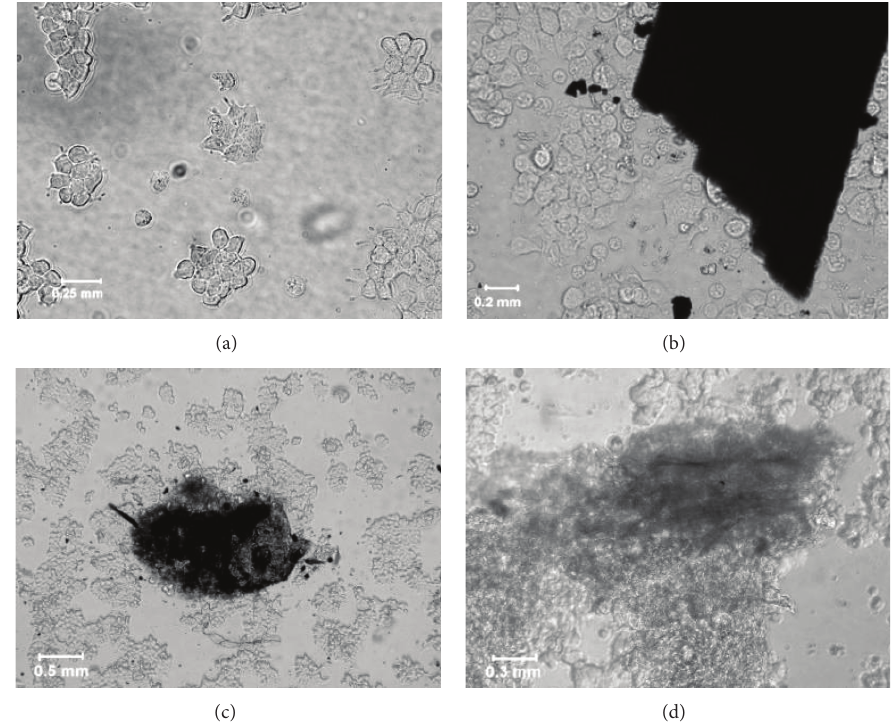
Figure 2: The rin-mf5 cell proliferation in presence of the C 60 (FeCp 2 ) 2 particles. (a) Cell proliferation (standard condition in monolayer). (b) Adhesion and growth of cells on the big crystal. (c) Influence of the crystals with size of nearly 5 𝜇 m on the cell proliferation. (d) Cell proliferation in presence of the C 60 (FeCp 2 ) 2 nanoparticles.